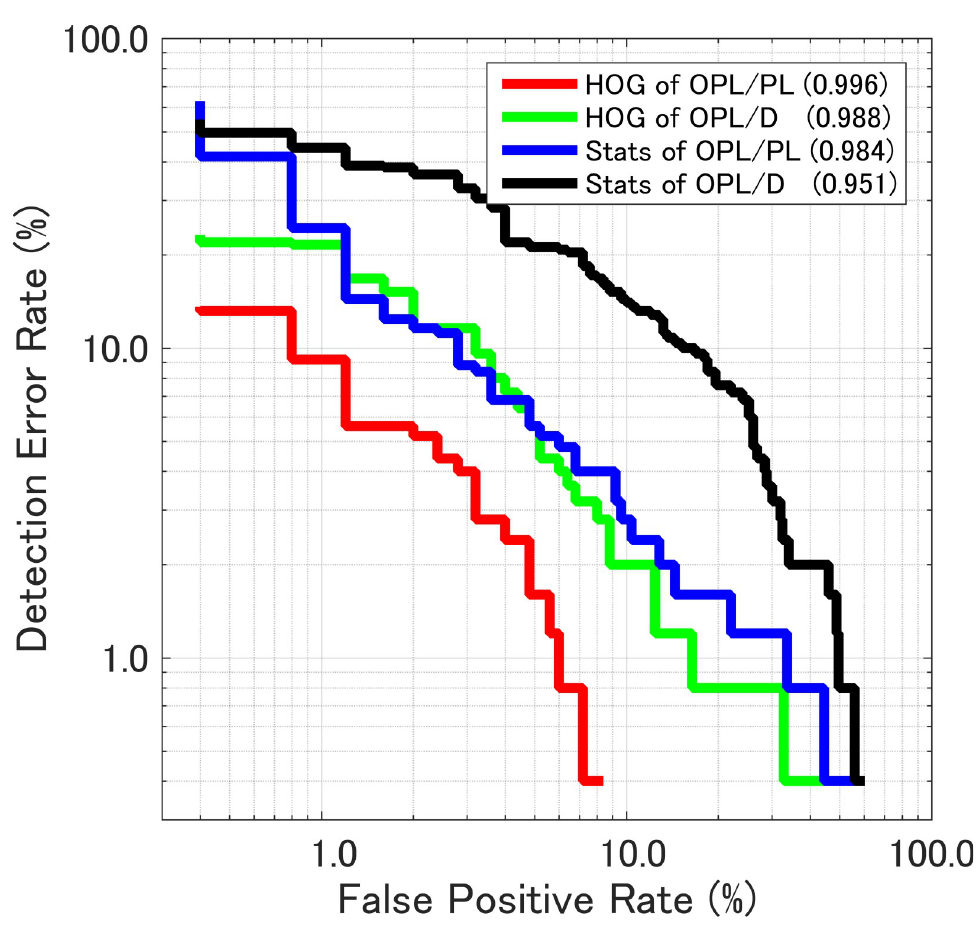
Fig 10. Detection-error trade-off (DET) curves for various training-data sets. Values in parentheses in the legend represent AUCs of their ROC curves.